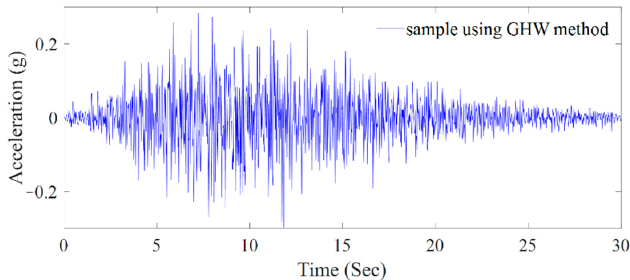
Figure 8. Typical sample by the GHW method.